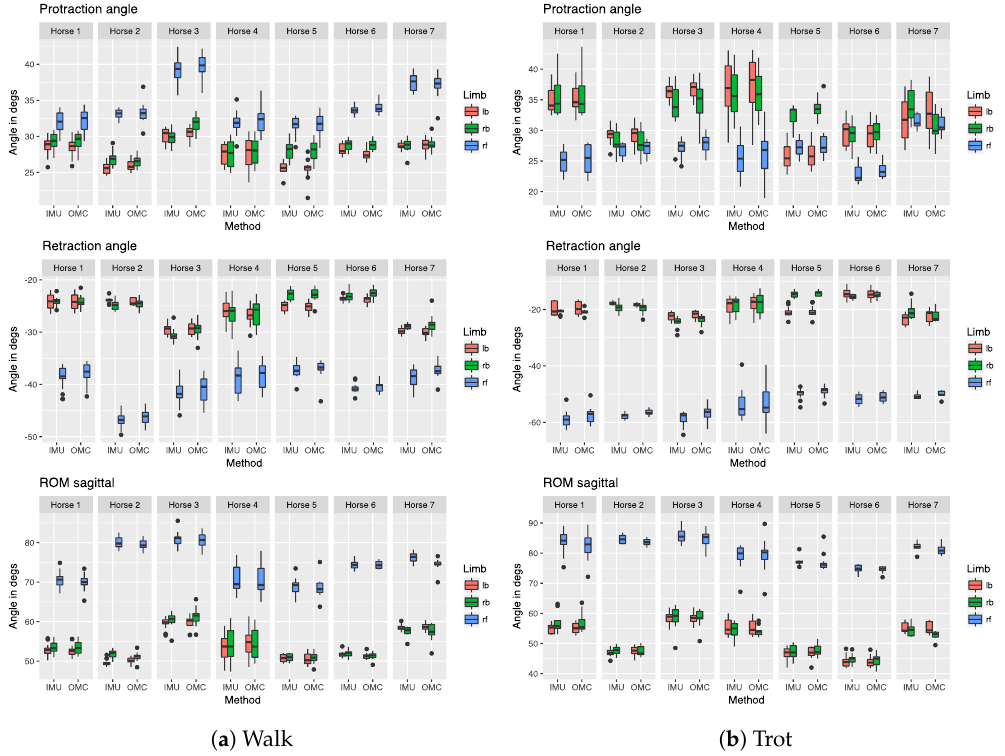
Figure A1. Box plots for the sagittal limb angles measured by IMU and